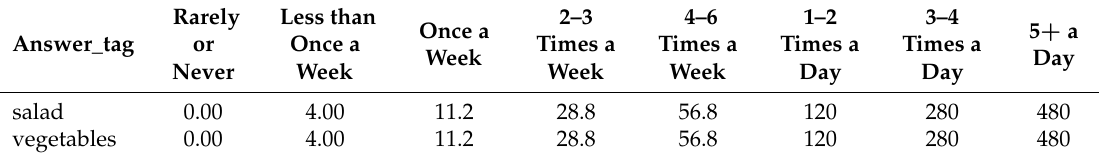
Table 1. Amounts of vegetable intake in grams for different frequencies of consumption.